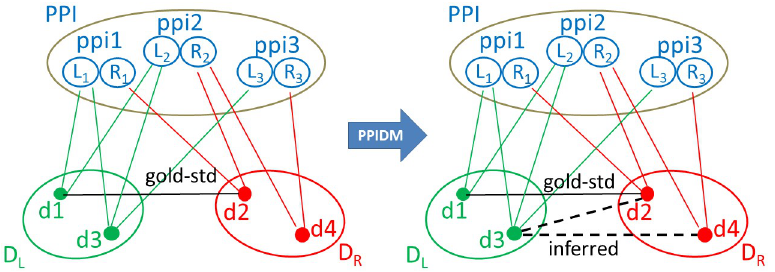
Fig 1. Schematic illustration of edge inference by PPIDM in a tripartite graph setting G ð X ; Y ; Z ; E Þ . Z is here PPI, a set of PPIs, X and Y are D L and D R , two sets of Pfam domains. Each item in PPI is an ordered pair of proteins ppi i = ( L , R ) with Id ( L ) � Id ( R ). Domains in D and D are connected to their common neighbor item ppi i i i i L R L i and R i respectively. The (d1, d2) edge comes from the Gold-Standard dataset of DDIs. With PPIDM, new edges are inferred between domains of